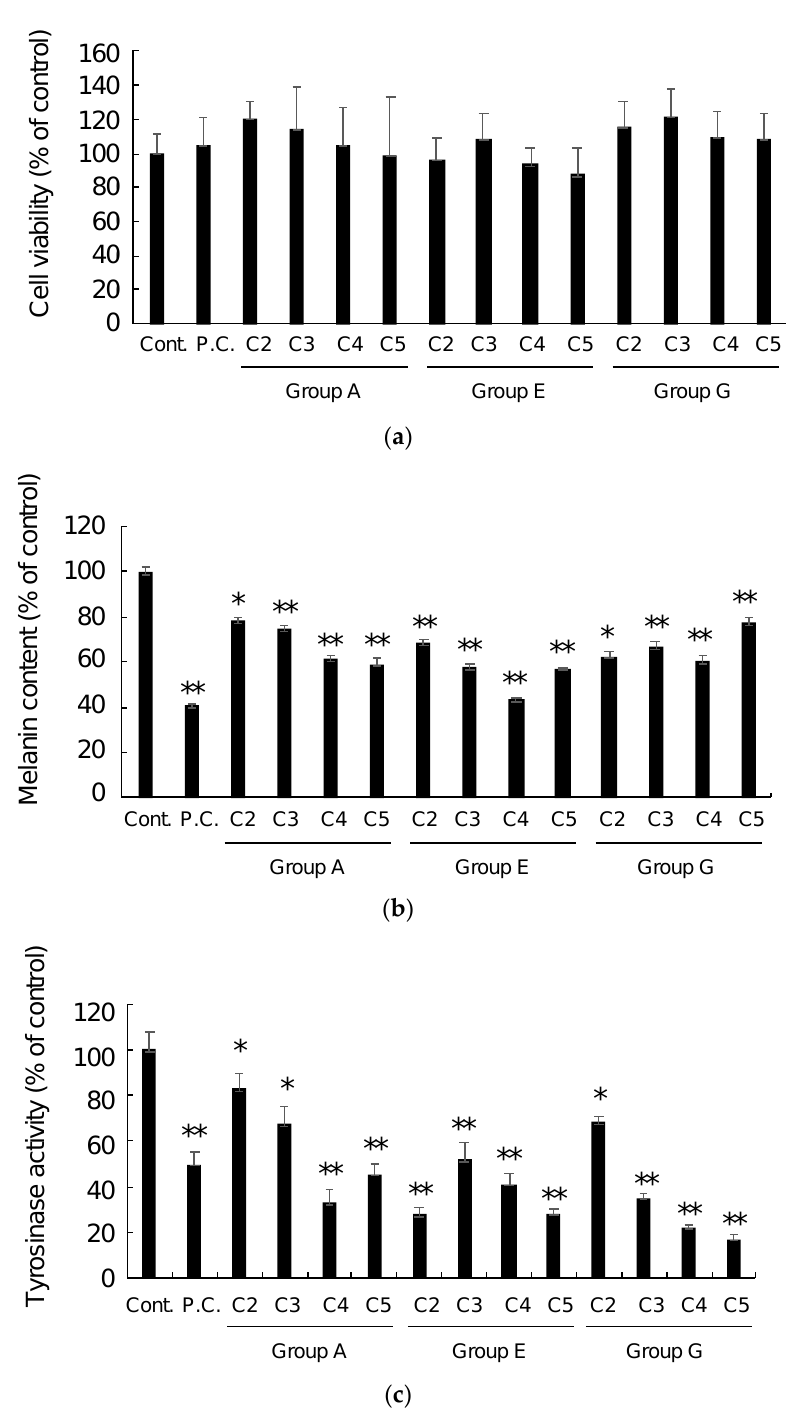
Figure 2. Effect of resorcinol derivatives on the cell viability of B16 melanoma cells ( a ), melanin content ( b ), tyrosinase activity ( c ). Data are the mean ± S.D. of three experiments, * p < 0.05, ** p < 0.01 versus control (Dunnett’s test).